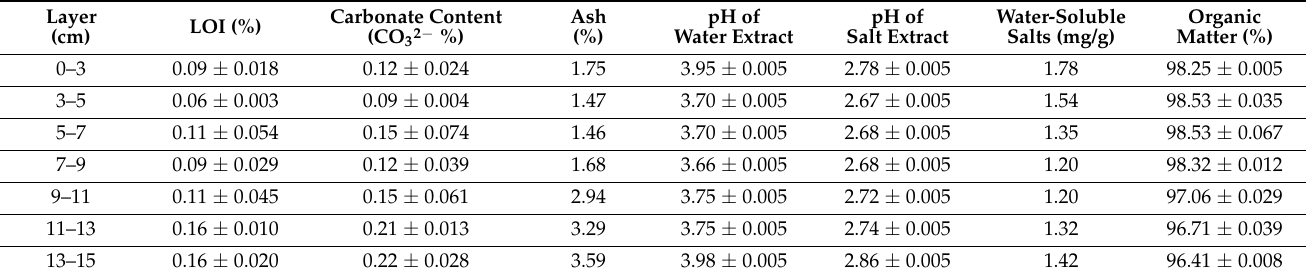
Table A1. The physicochemical parameters of the peat